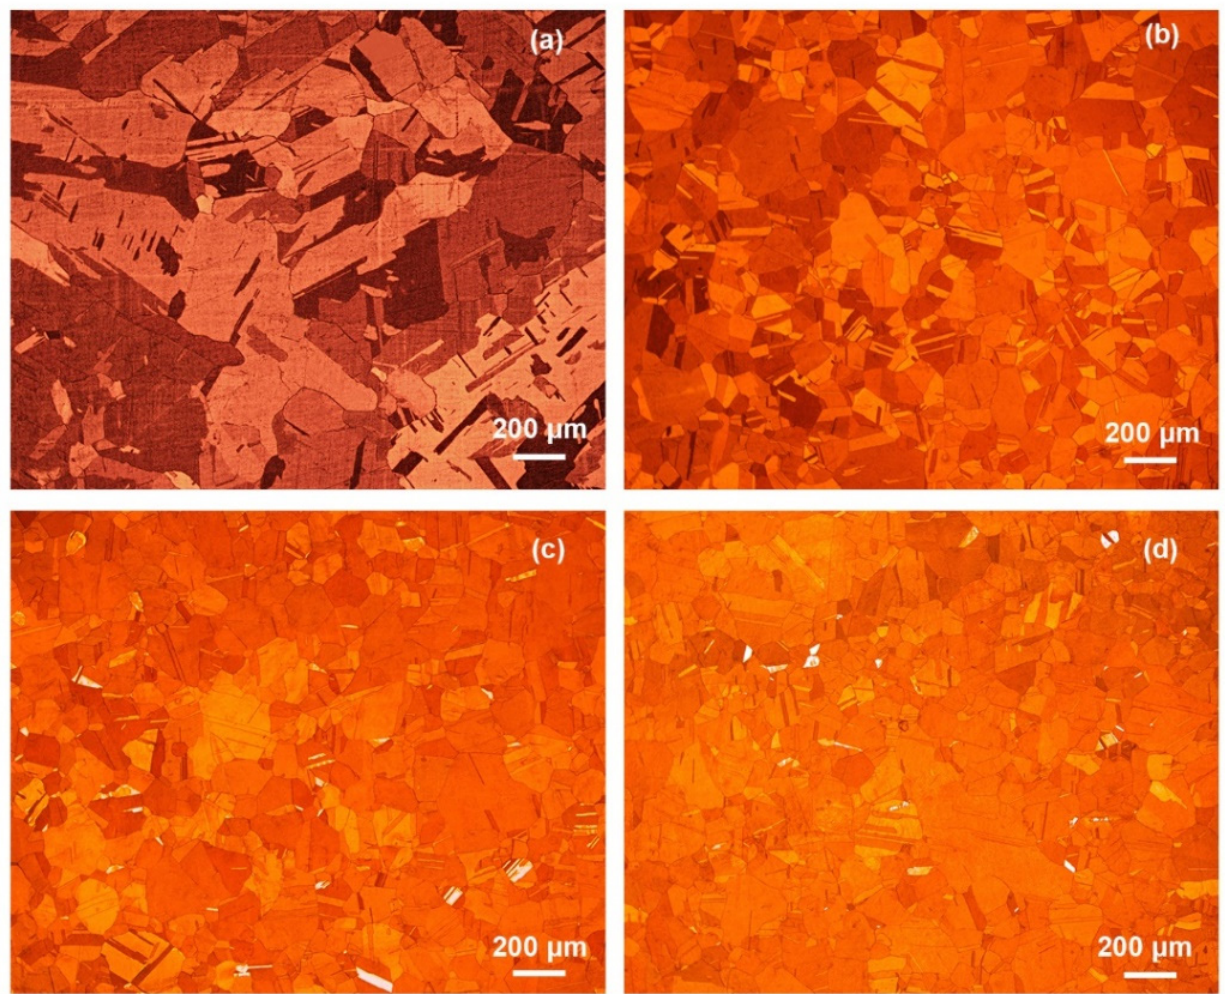
Figure 2. The optical micrographs of specimens intermediate annealed at 500 °C for 5 min: ( a ) pure Cu, ( b ) P23, ( c ) P52, and ( d ) P100.